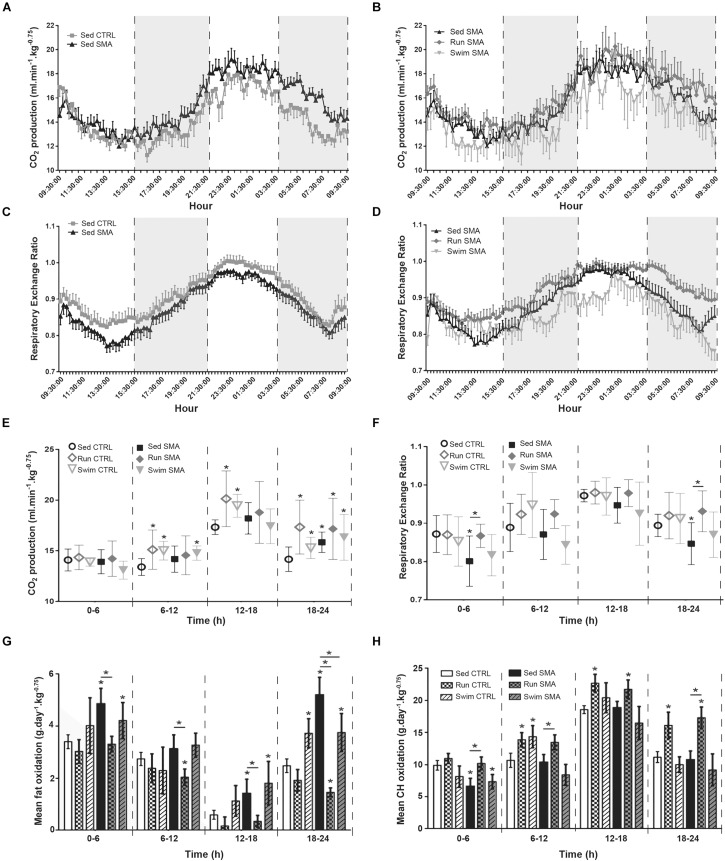
Nutrients oxidation measurements in sedentary and trained SMA and control mice. (A,B) 24 h carbon dioxide production of (A) sedentary control and SMA mice and (B) Sed SMA compared to Run SMA and Swim SMA mice at 12 months of age. Black dotted lines and gray background delimit periods of 6 h (9 h 30–15 h 30, 15 h 30–21 h 30, 21 h 30–3 h 30 and 3 h 30–9 h30). (C,D) 24 h respiratory exchange ratio of (C) sedentary control and SMA mice, and (D) Sed SMA compared to Run SMA and Swim SMA mice at 12 months of age. (E,F) Quantification of carbon dioxide production (E) and respiratory exchange ratio (F) according to periods of 6 h from 12 months old sedentary and trained control and SMA mice. (G,H) Quantification of mean fat oxidation (G) or carbohydrate oxidation (H) according to periods of 6 h from 12 months old sedentary and trained control and SMA mice (n = 12 for sedentary mice, n = 12 for Run CTRL, n = 8 for Run SMA and n = 6 for Swim mice). ∗ and -∗- Indicated significance relative to sedentary control and SMA mice, respectively (with P < 0.05).